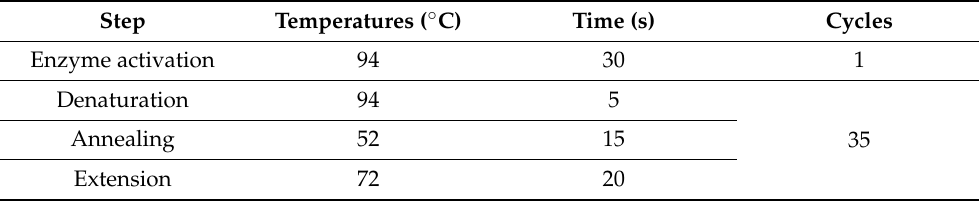
Table 2. Thermal profile of Bla and Bla CTX-M-15 genes